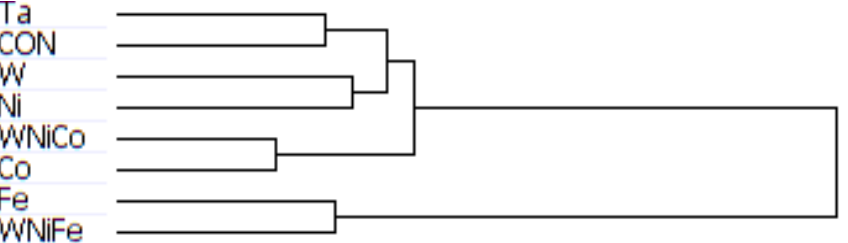
Figure 3. Dendrogram from hierarchal clustering analysis of mouse microarray